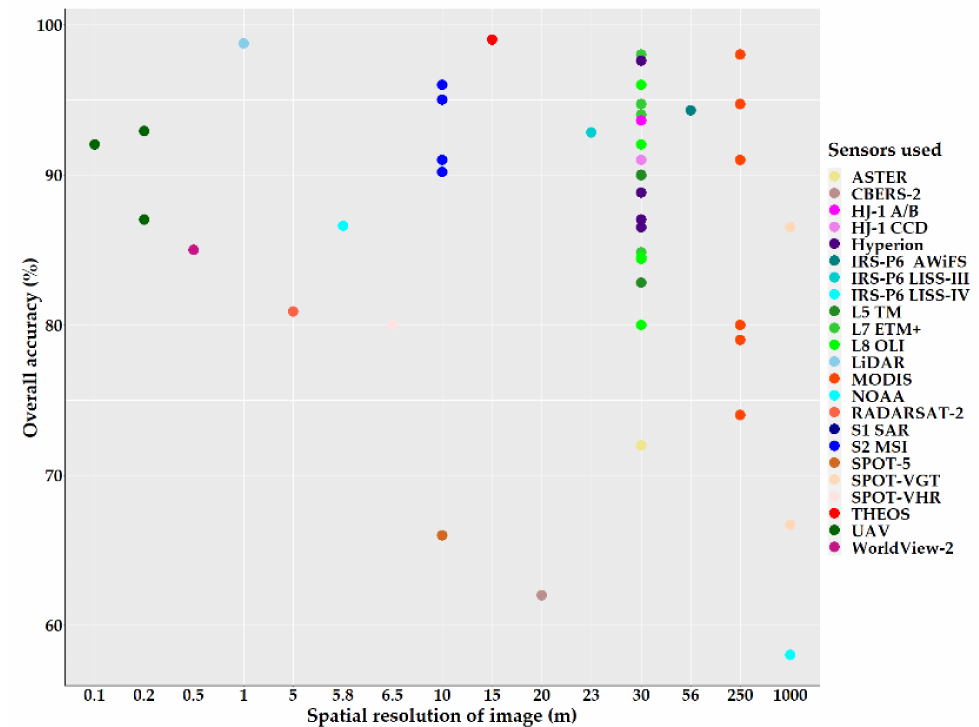
Figure 16. Relation between overall accuracy (OA) (%) and spatial resolution of the image data in meter (m).